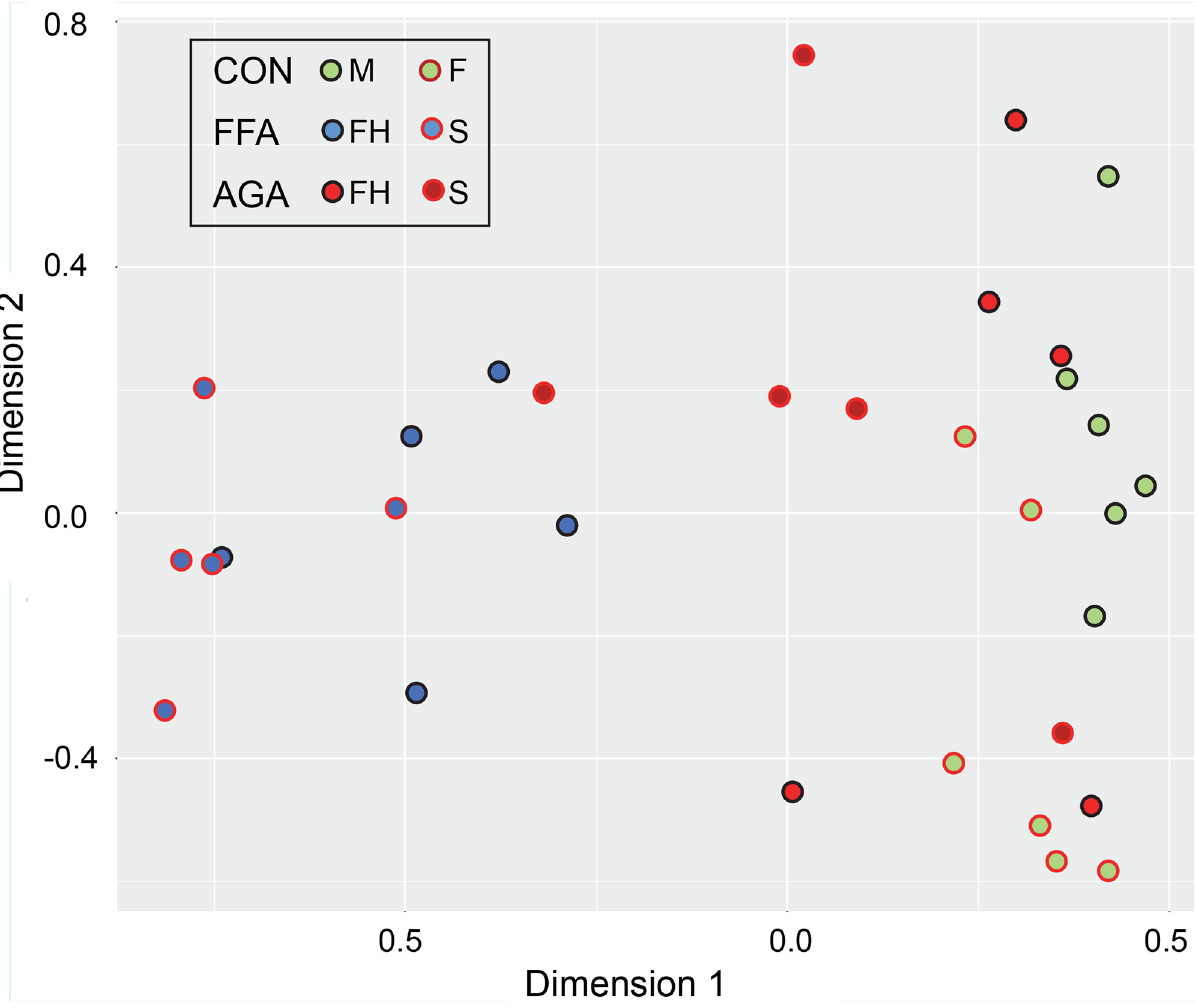
Fig 1. Multidimensional plot of data from forehead samples. Although definite interindividual differences among subjects are seen, particularly noticeable in the AGA cohort, a clear separation is evident between FFA and control